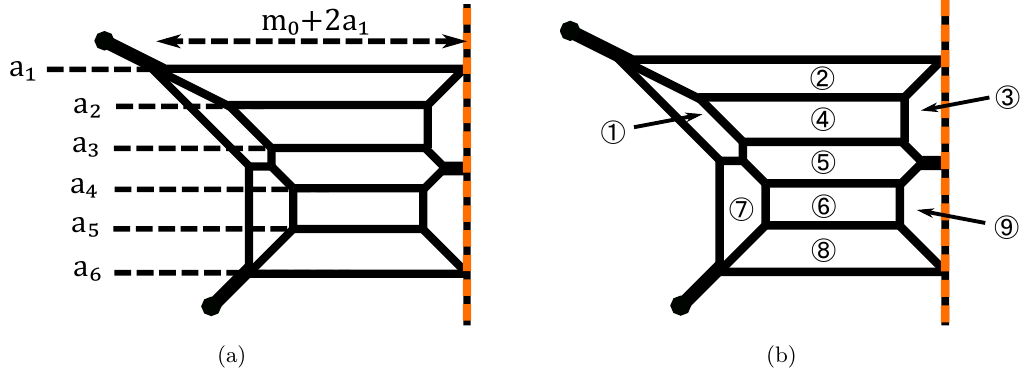
Figure 11 . (a) A parameterization of Coulomb branch moduli for the diagram in (cid:12)gure 9(b). (b) A labeling for the area of faces in the diagram in (cid:12)gure